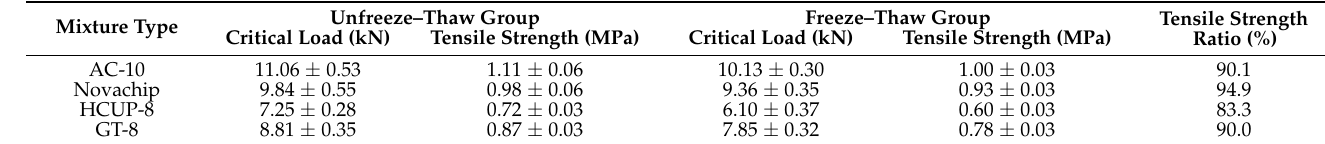
Table 9. Tensile strength test results.